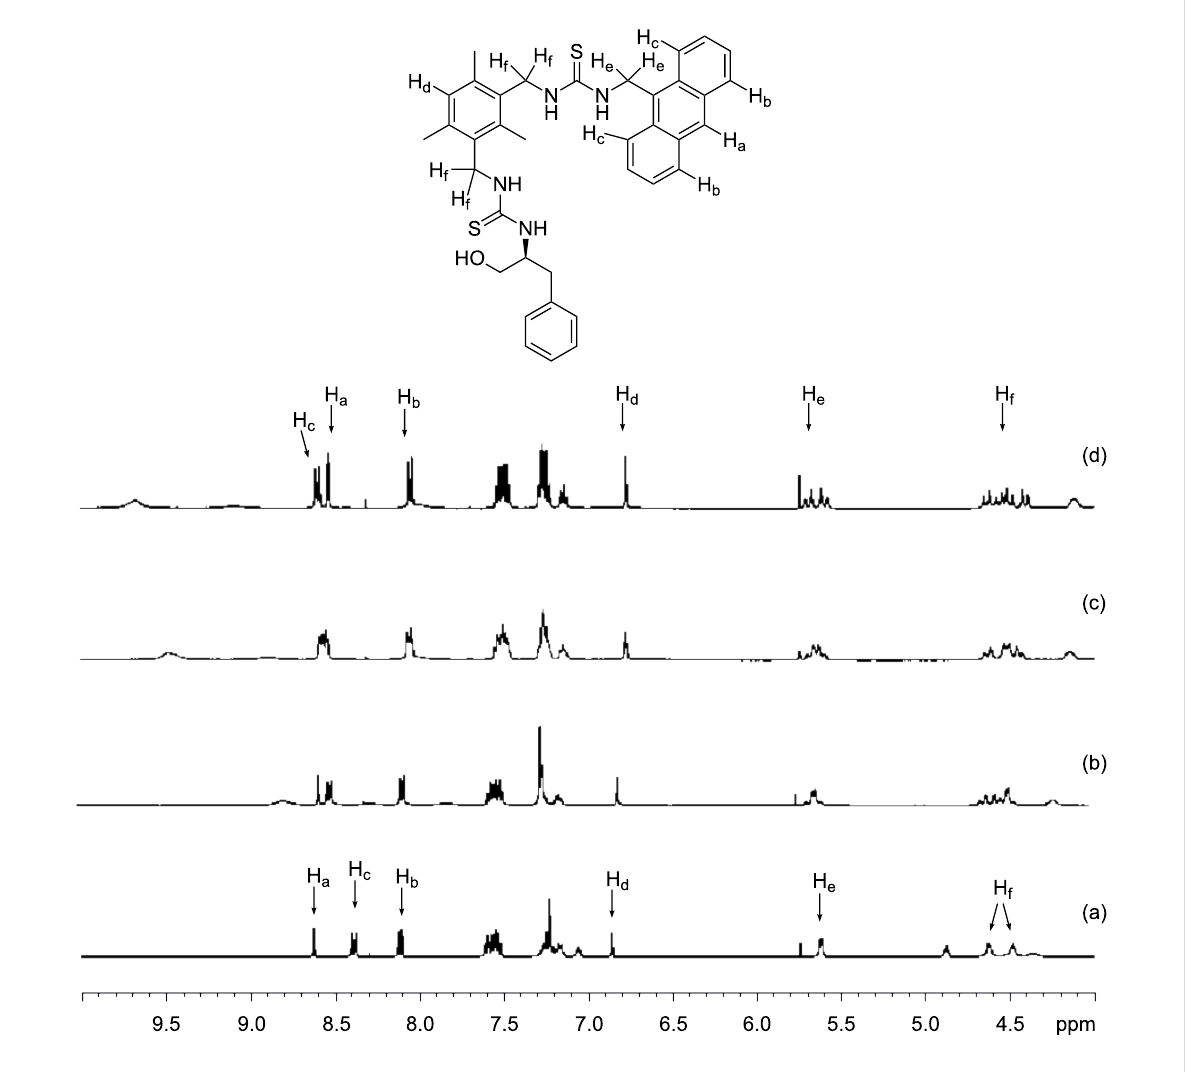
Figure 3: Partial 1 H NMR spectra for (a) sensor 2 (free, 3 mM), (b) sensor 2 + 0.5 equiv D-glutamate, (c) sensor 2 + 1.0 equiv D-glutamate, (d) sensor 2 + 1.0 equiv L-glutamate in DMSO- d 6 .